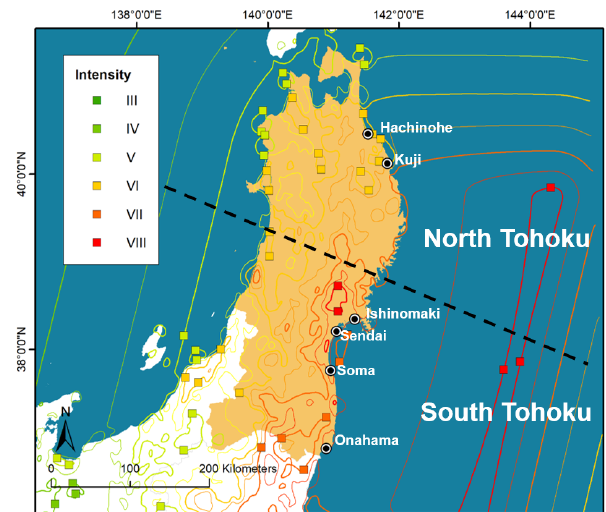
Figure 10. Mercalli intensities (MI) recorded by United States Ge- ological Survey (USGS, 2020) for the Great East Japan earthquake and tsunami. Earthquake intensities differ between the northern (MI VI) and southern (MI VII–VIII) regions of Tohoku. North Tohoku experiences less effects from ground shaking than in the